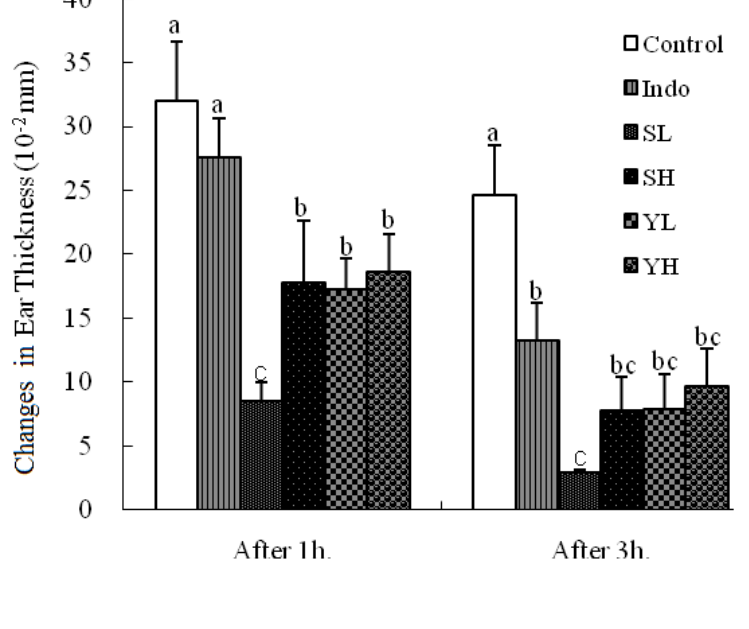
Figure 1. Effects of SoRiTae and Yak-Kong ethanolic seed extracts on arachodonic acid- induced ear edema. Indo: Indomethacin (10 mg/kg); SL: SoRiTae (100 mg/kg); SH: SoRiTae (200 mg/kg), YL: Yak-Kong (100 mg/kg), YH: Yak-Kong (200 mg/kg). Each values was expressed as the mean ±S.E.M. (n = 6). a-c Means in the same column not sharing a common letter are significantly different (p < 0.05) by Duncan's multiple